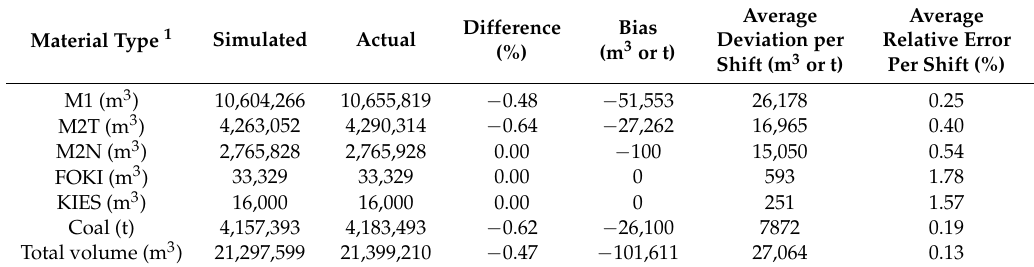
Table 11. Summary statistics of the simulated and the actual production data of the Hambach case, Exp. 1.